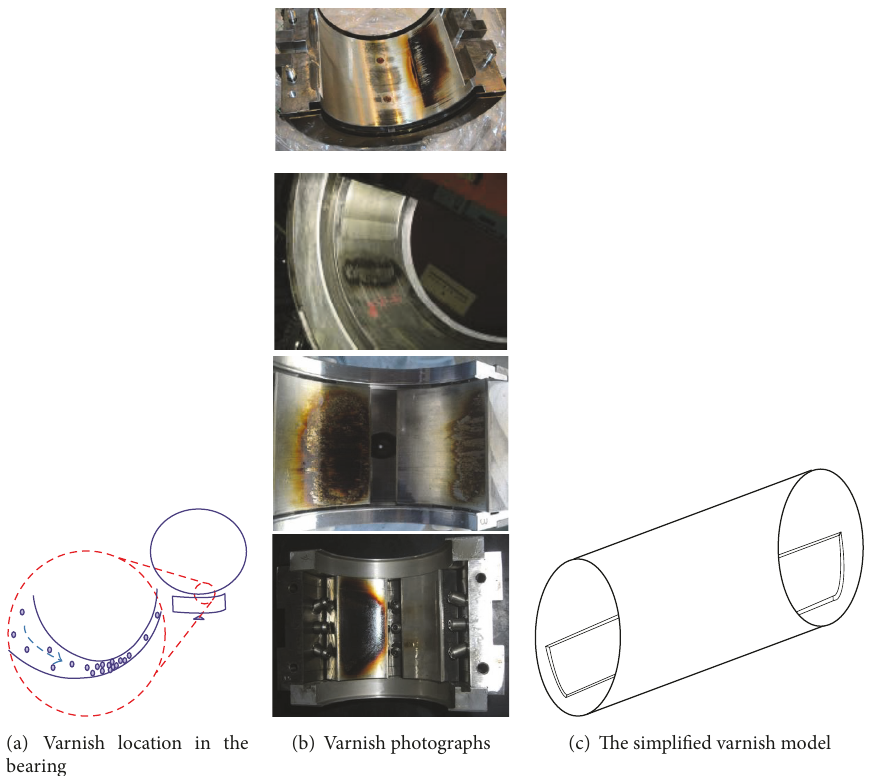
Figure 1: Bearing varnish